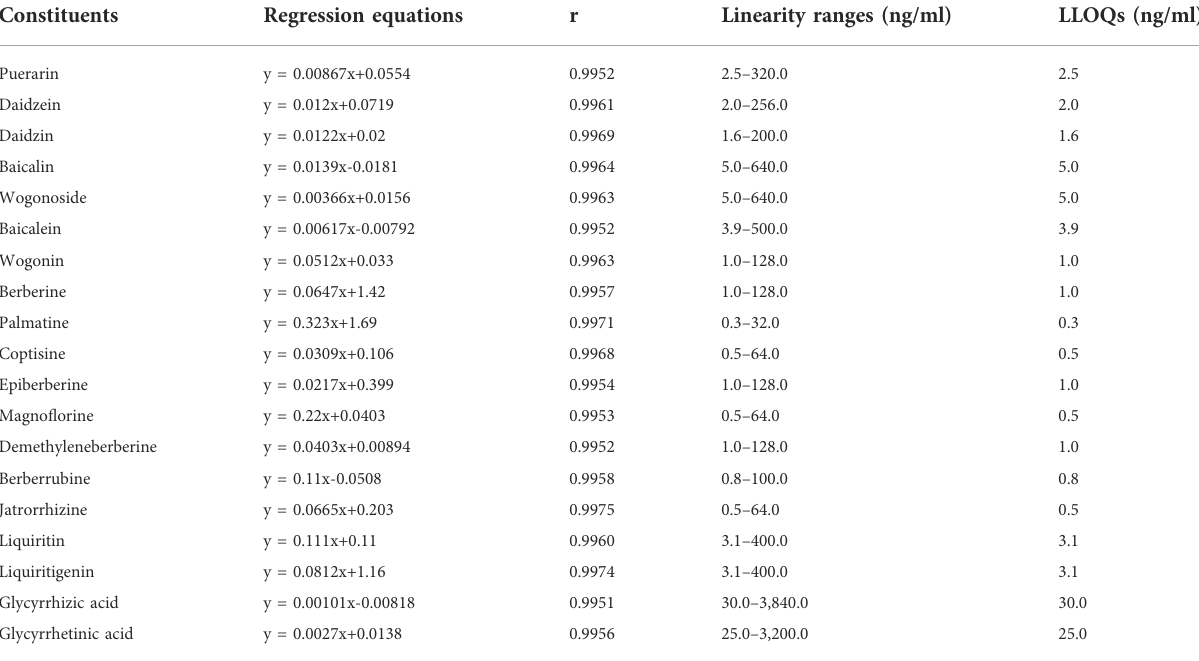
TABLE 1 Standard curves, linear ranges, and lower limit of quanti fi cation (LLOQ) of the constituents of Gegen-Qinlian decoction in blank mouse plasma (n = 6). Constituents Regression